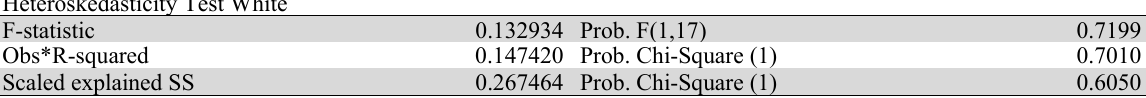
Heteroscedasticity test Heteroskedasticity Test White